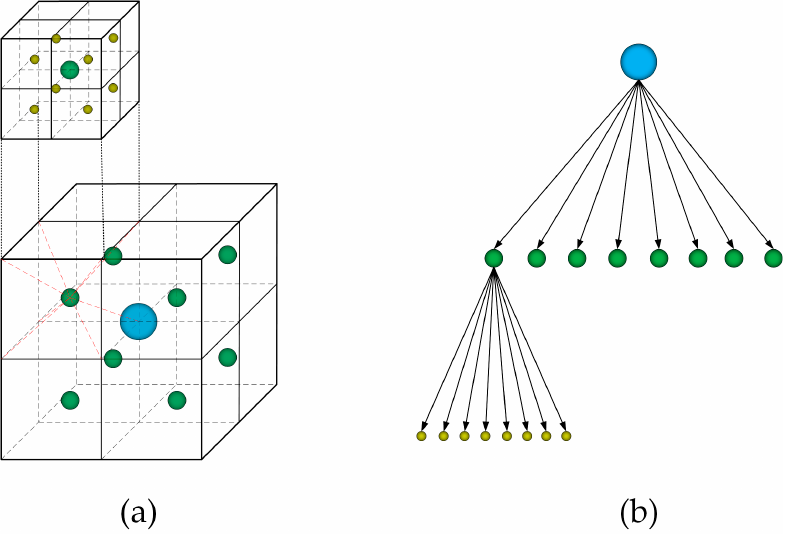
Figure 3. 3D multi-level grid storage format: ( a ) 3D multi-level grid; ( b ) octree storage format.